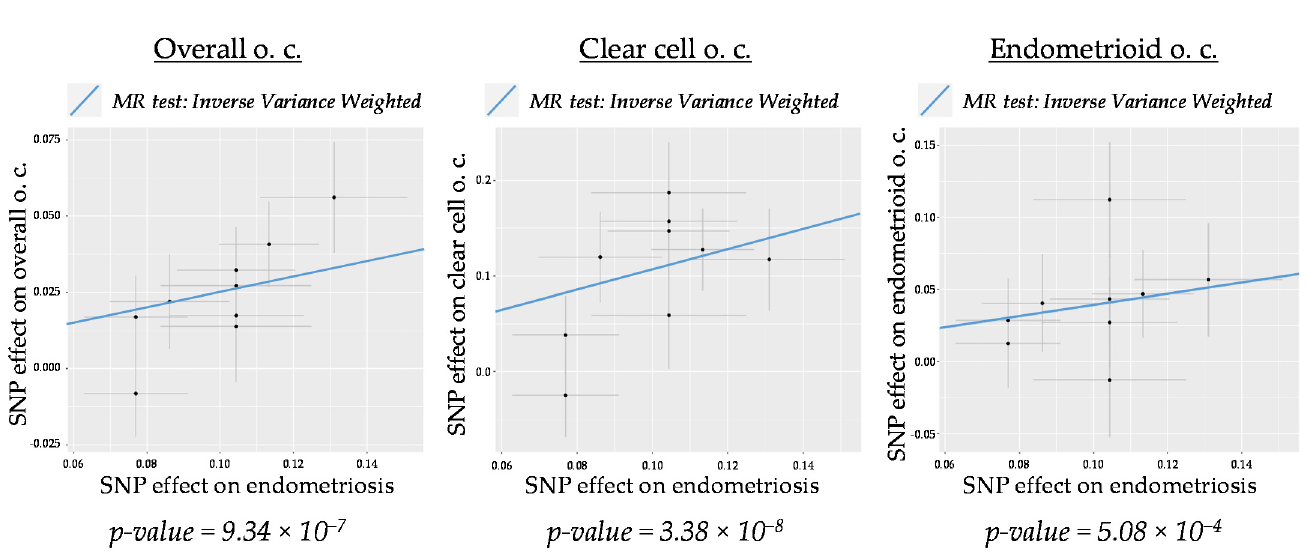
Figure 2. Scatter plots for 2SMR analyses of the causal effect of endometriosis on overall, clear cell and endometrioid ovarian cancer (o. c.). The slope of the line corresponds to the estimated MR effect (beta value) calculated with the inverse variance weighted method.